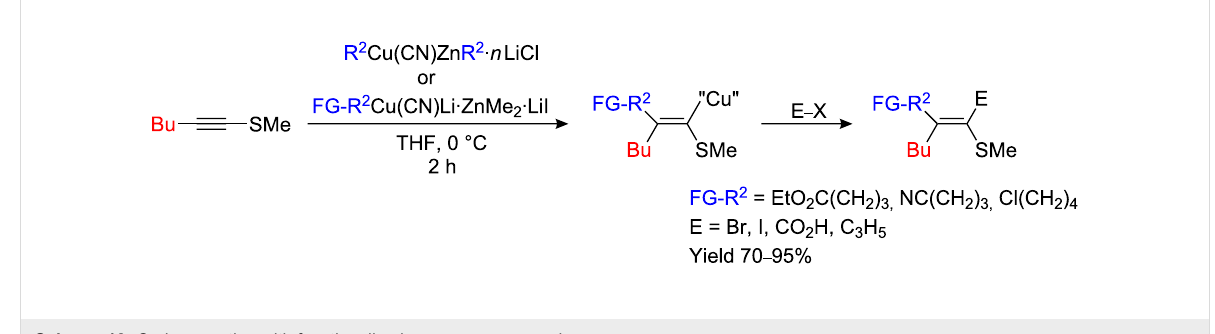
Scheme 18: Carbocupration with functionalized organocopper